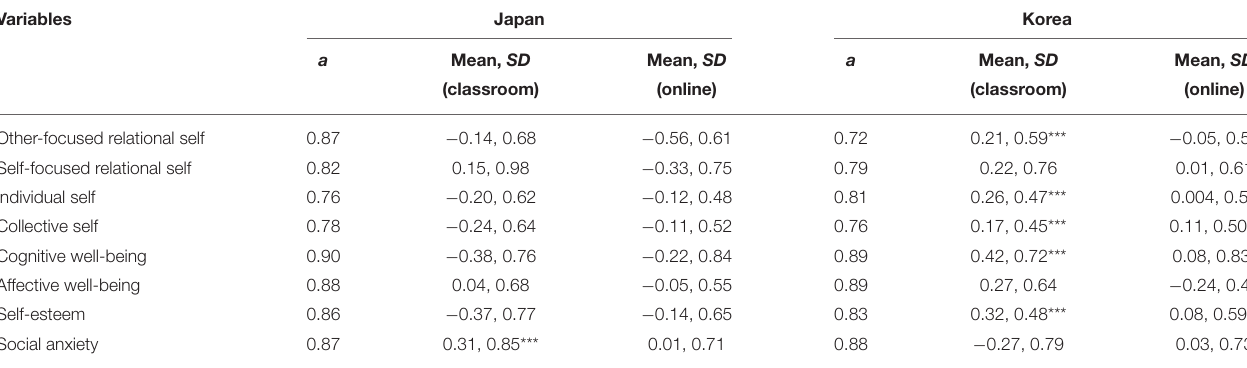
TABLE 1 | Reliabilities and means of main variables for each culture (Japan, Korea) and collection method (classroom, online). Variables